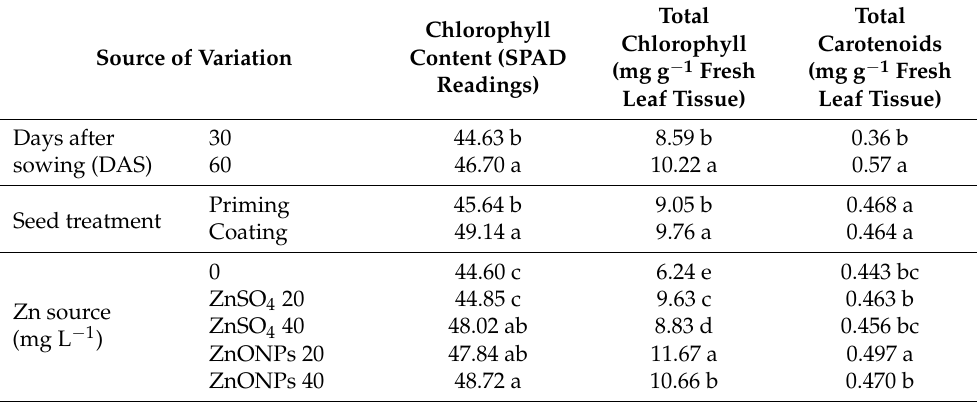
Table 3. Effect of application of different concentrations of ZnONPs on chlorophyll fluorescence measured with Soil Plant Analysis Development (SPAD) meter and total chlorophyll and carotenoid contents in maize var. J-1006.